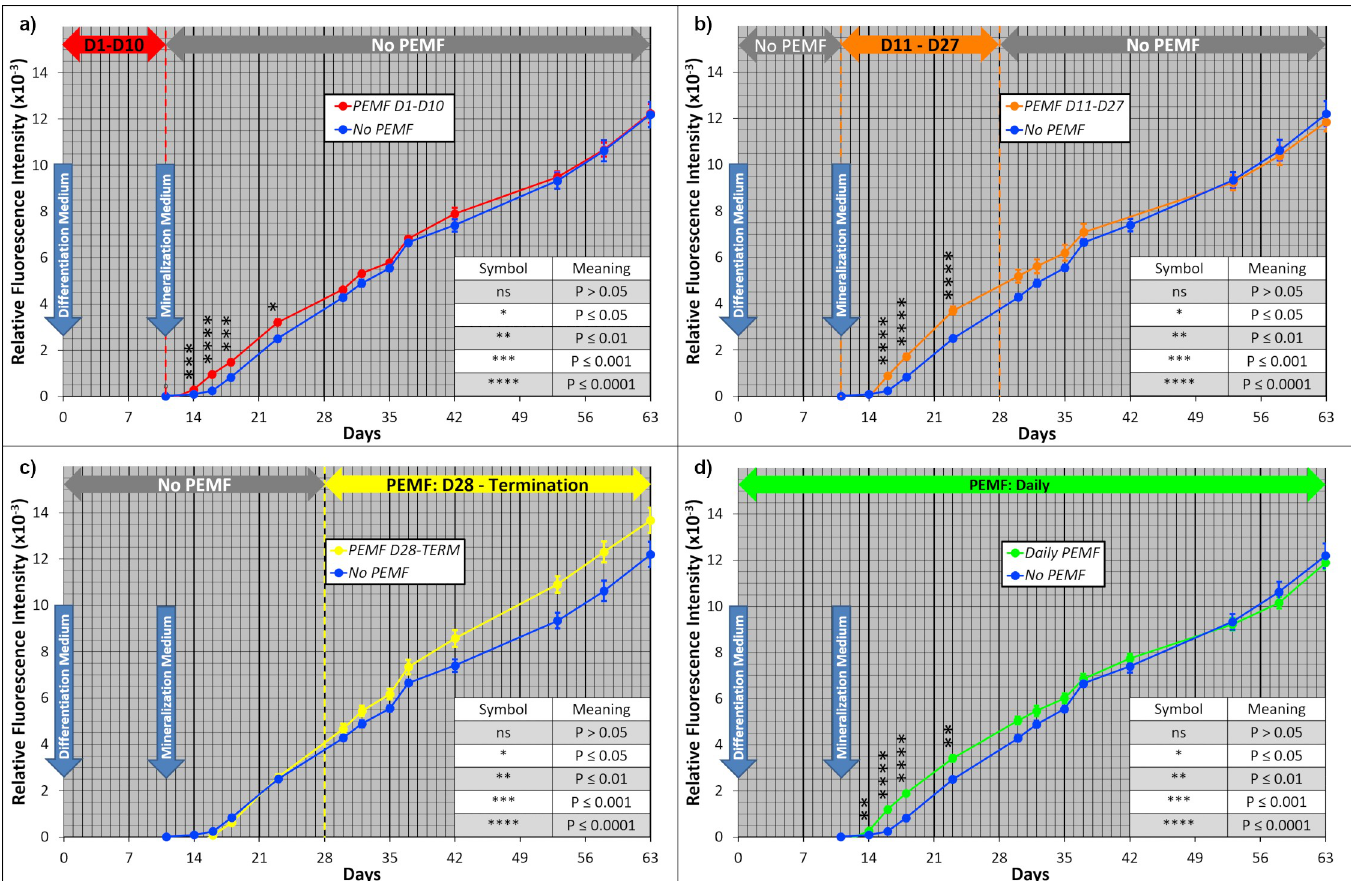
Fig 4. Effect of PEMF on mineralization measured by intravital ARS fluorescence. PEMF was applied to ring cultures according to Protocols A, B, C, and D, and the resultant ARS fluorescence is presented in panels (a), (b), (c), and (d); in each case compared to no-PEMF control cultures. In each case, n = 12 between Day 1 and Day 10; n = 9 between Day 11-Day and Day 27; and n = 6 between Day 28 and Day 63. Standard Error bars are presented with significance indicated by asterisks in the legend.